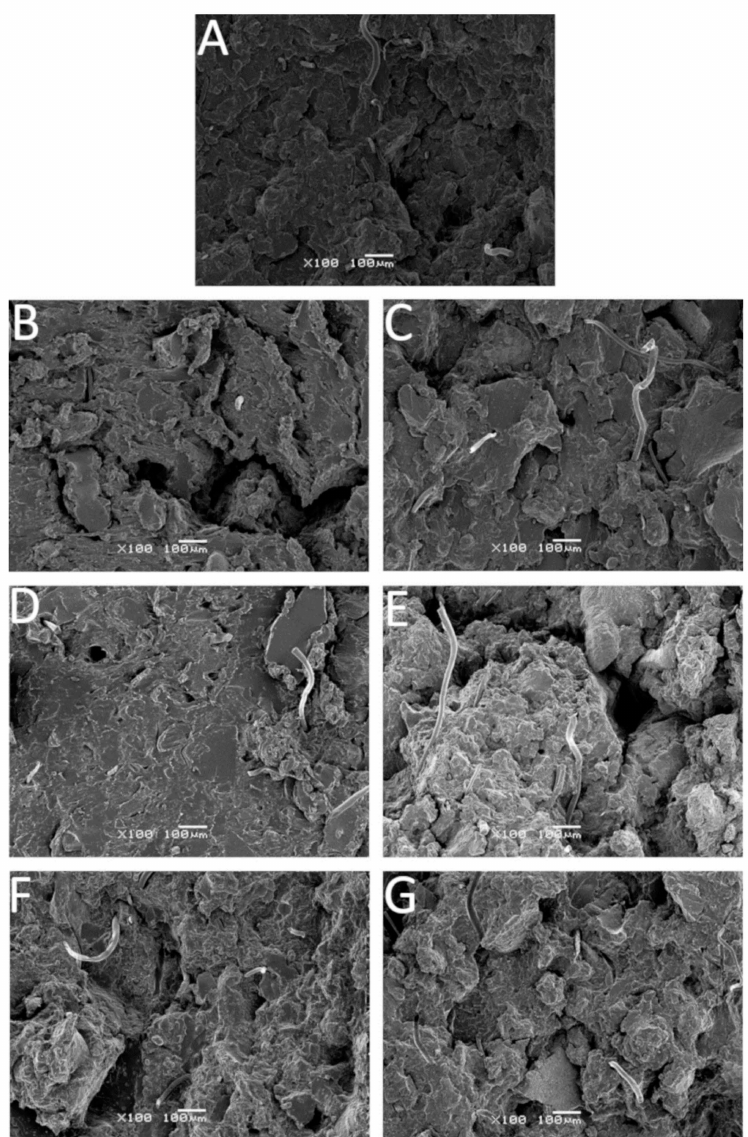
Figure 6. SEM images of samples: ( A )—GTR; ( B )—GTR / TOR; ( C )—GTR / TOR S ; ( D )—GTR / TOR CBS ; ( E )—GTR / TOR MBTS ; ( F )—GTR / TOR SDT ; ( G )—GTR / TOR S80 (magnification × 100). Abbreviations: GTR—ground tire rubber; TOR—trans-polyoctenamer